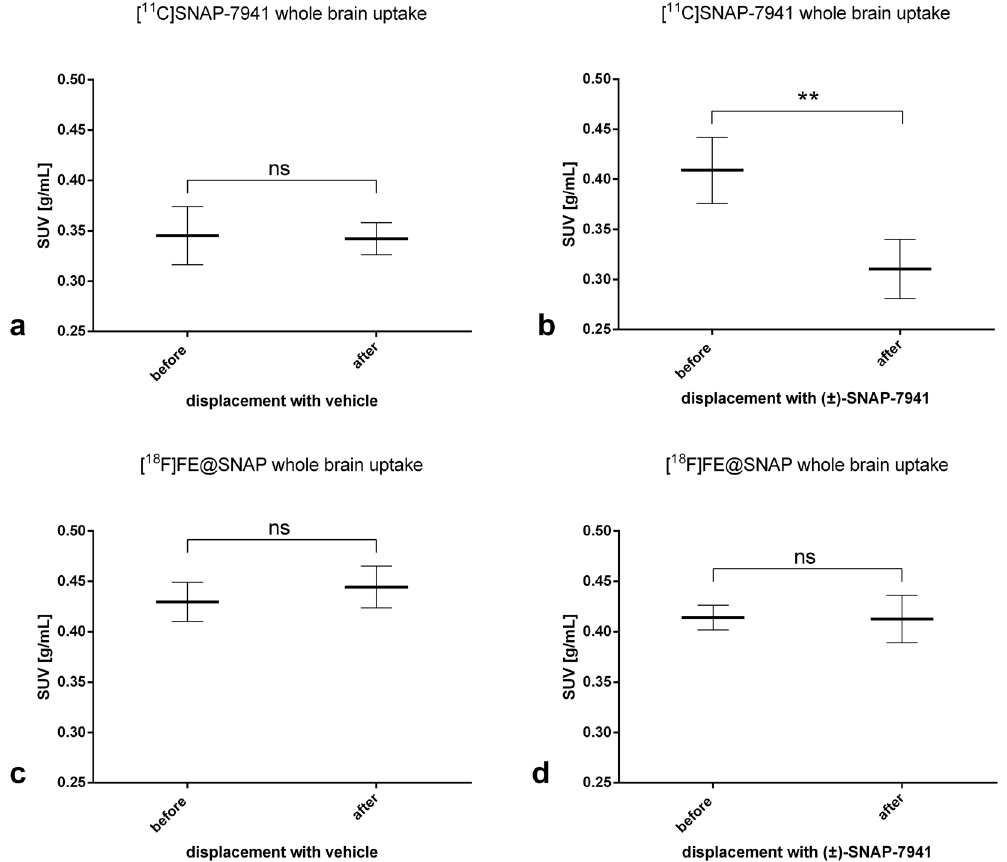
Figure 6. Radiotracer uptake in the whole brain. Whole brain uptake of [ 11 C]SNAP-7941 before and after displacement with either vehicle ( a ) or 15 mg/kg ( ± )-SNAP-7941 ( b ) and [ 18 F]FE@SNAP before and after displacement with either vehicle ( c ) or 15 mg/kg ( ± )-SNAP-7941 ( d ). Data are displayed as mean ± SEM from independent experiments (n ≥ 3). Differences among groups were tested using a two-tailed parametric paired t-test (ns = P > 0.05; ** P < 0.01). If not visible, error bars are within the margin of the